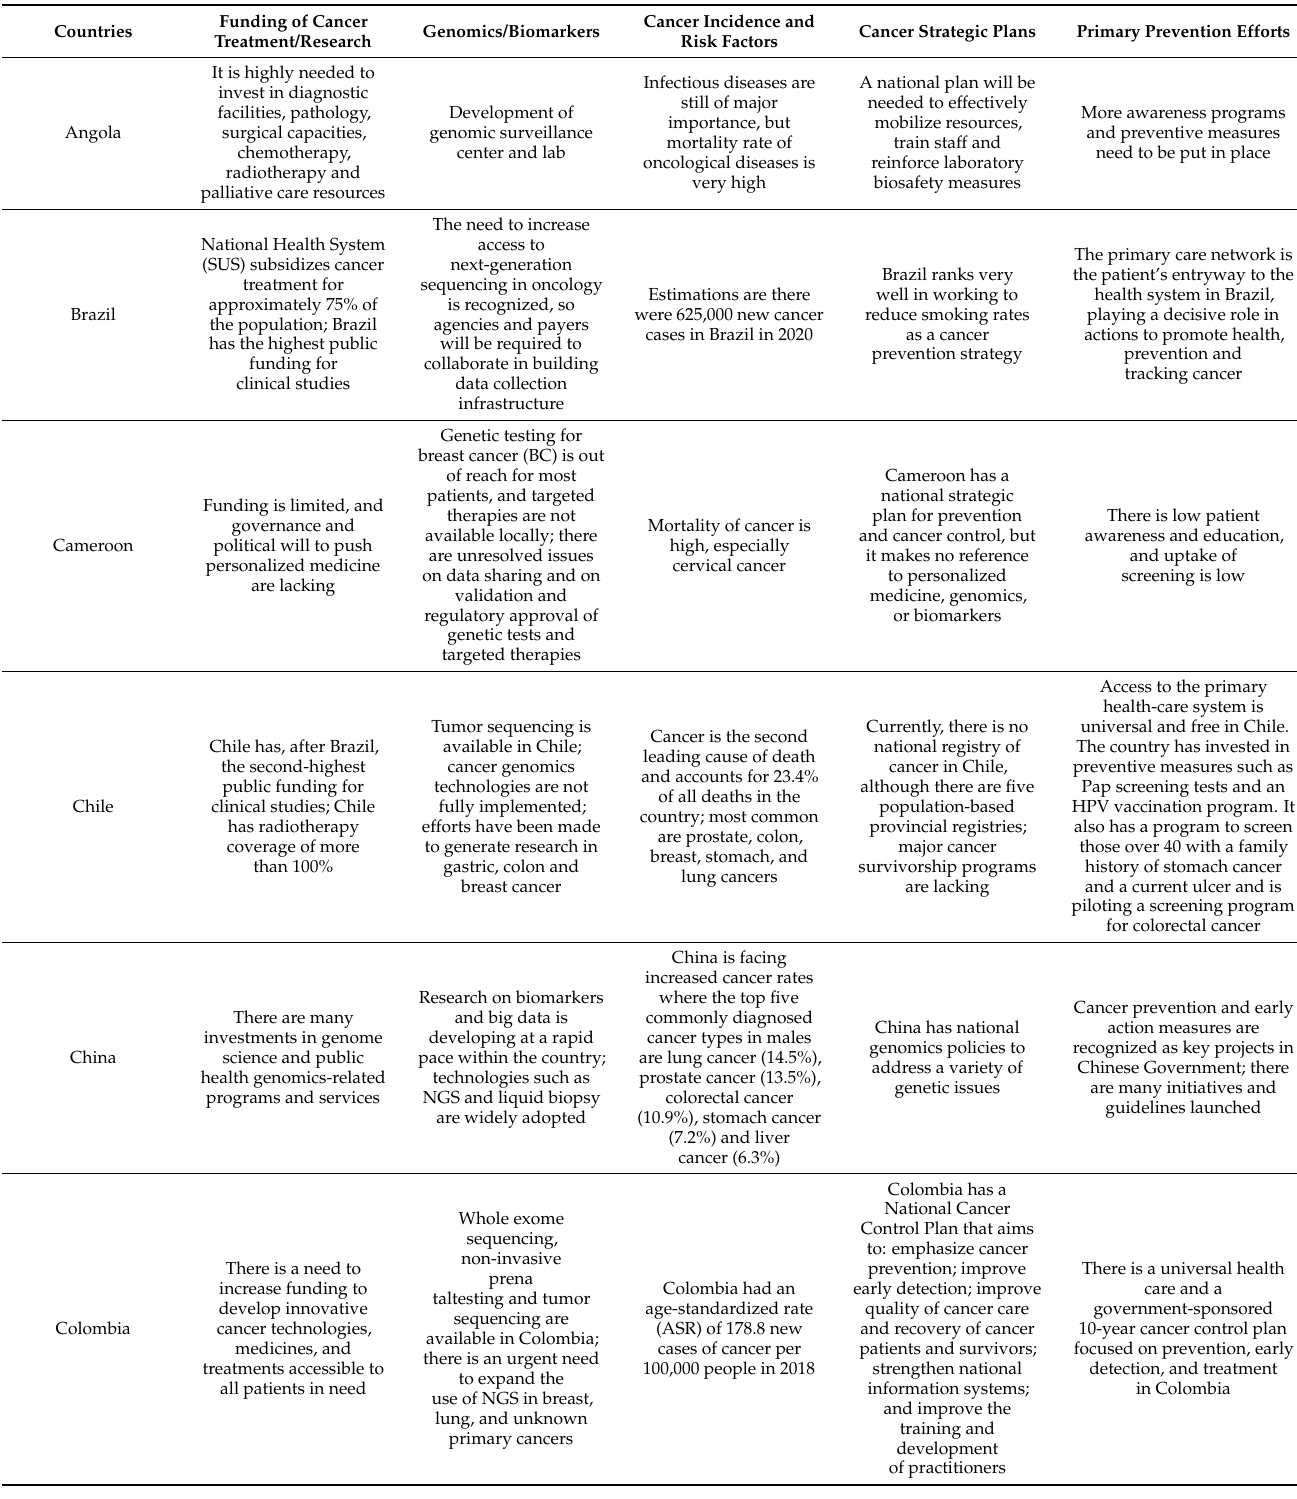
Table 5. Situation regarding different key factors in tackling cancer addressed in different countries. Countries are listed in alphabetical order regardless of the